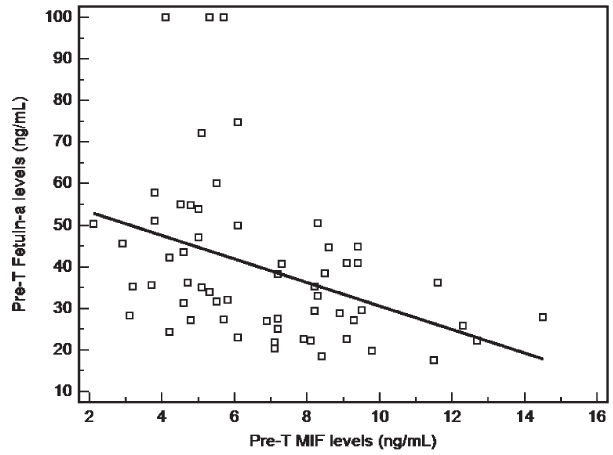
A (r= 2 0.4, P =0.002).